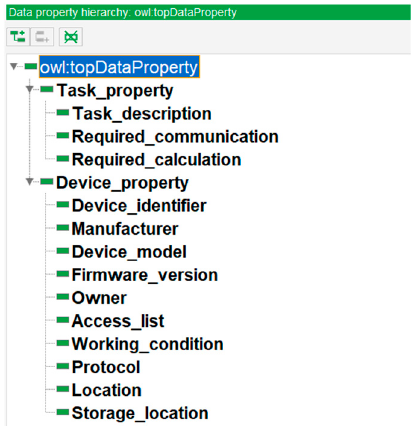
Figure 5. IoT device ontology data